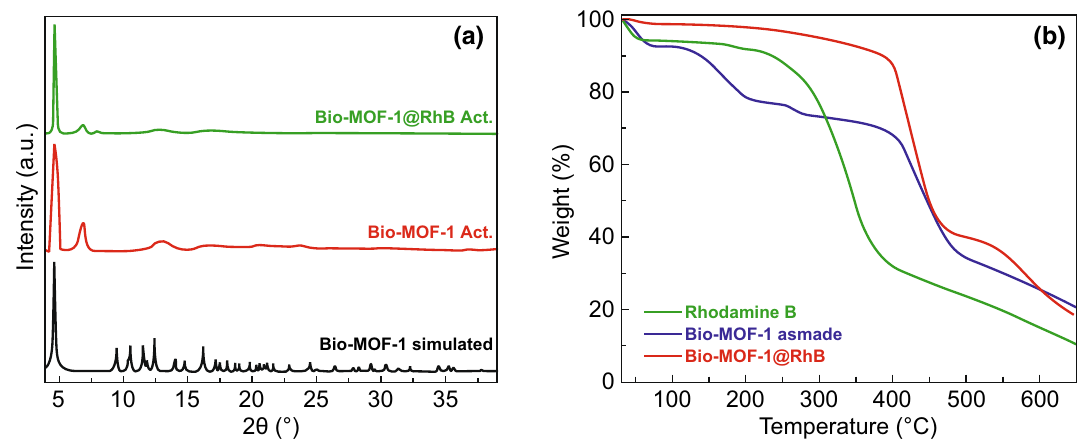
Fig. 12 a PXRD pattern of Bio-MOF-1 simulated (black), Bio-MOF activated (brown) & Bio-MOF@RhB activated (green). b TGA profiles of as-made Bio-MOF-1 (blue), RhB (green) & Bio-MOF@RhB (brown). Reprinted with permission from Ref. [33]. Copyright 2020, Elsevier. (Color figure